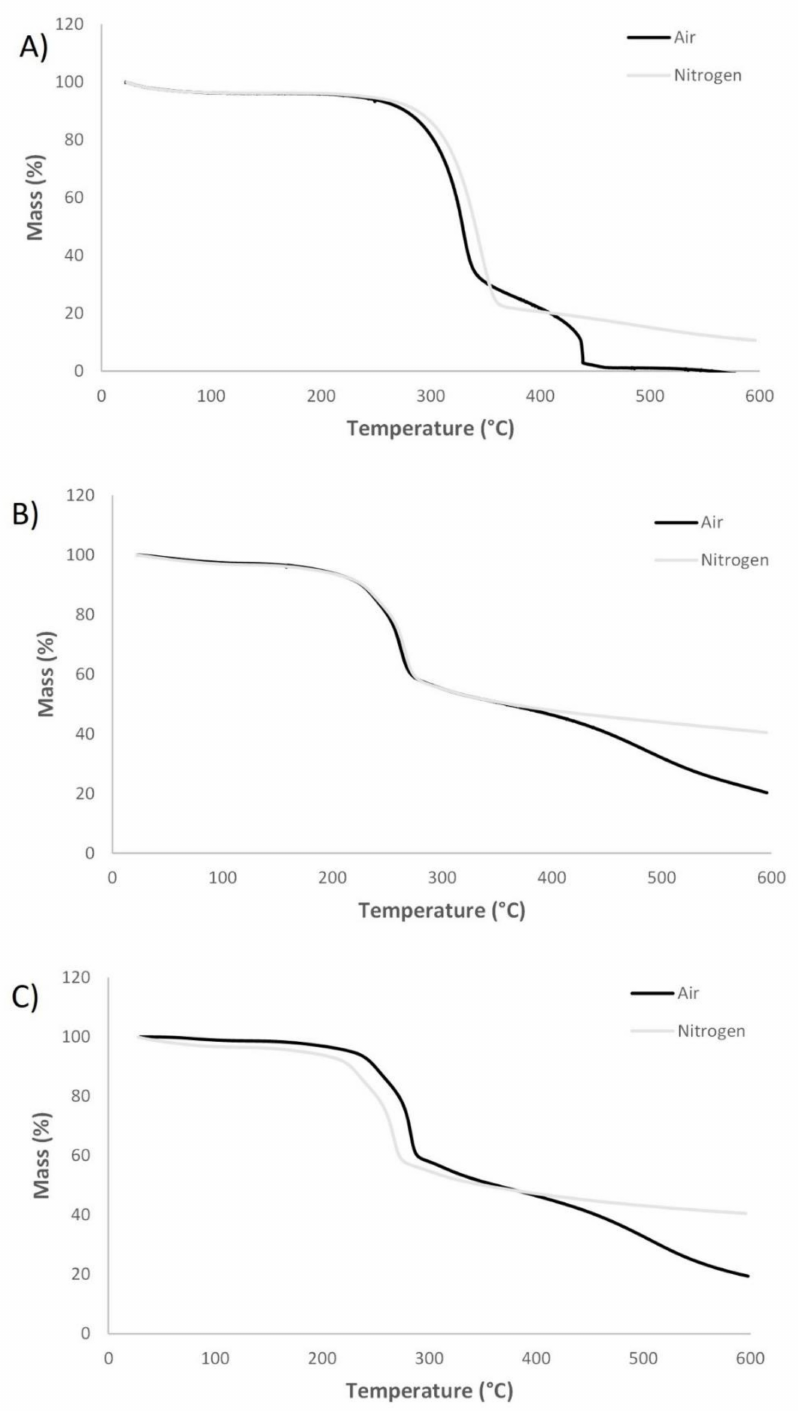
Figure 6. TGA curves of cotton in air and nitrogen ( A ), cotton finished with modified sorbitol in air and nitrogen ( B ) and cotton finished with modified isosorbide in air and nitrogen ( C